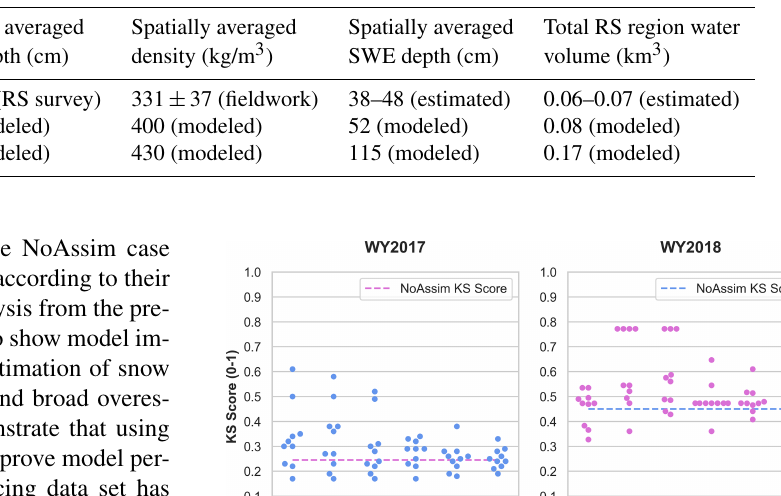
Table 3. Spatially averaged variables in the RS region. The spatially averaged results were calculated using the RS region in WY2018, the RS data set ( ± 1cm error), the spatially averaged density, and the modeled results. The spatially averaged SWE depth for the RS survey was estimated using the average density ( ± 11.2%) measured during April 2018 fieldwork.